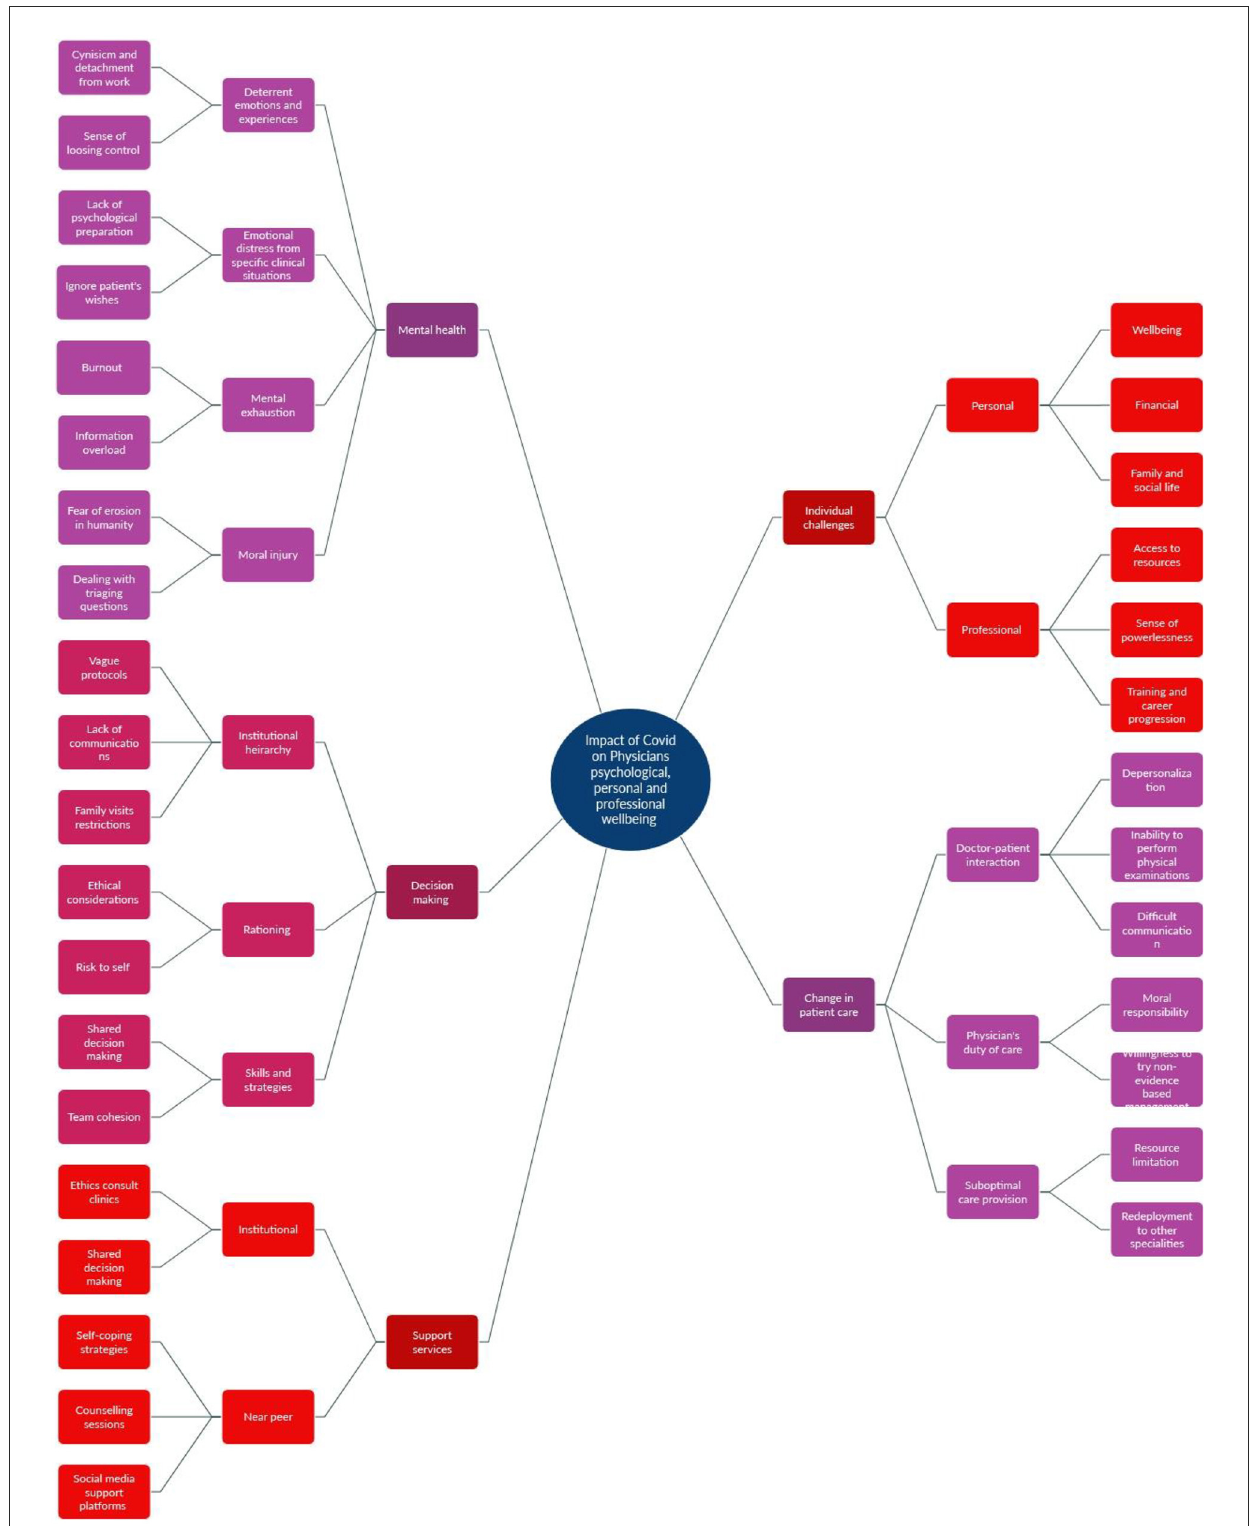
FIGURE4 Thematic analysis using a grounded theory approach.